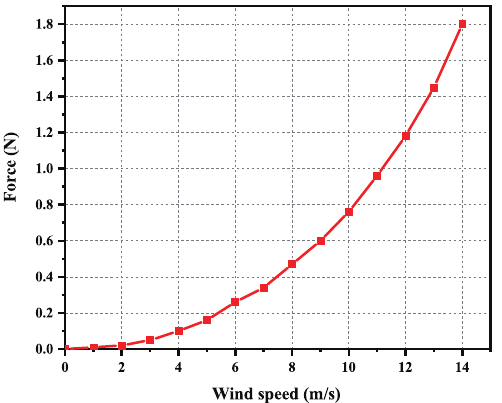
Figure 19. Robot barrier-free upwind test